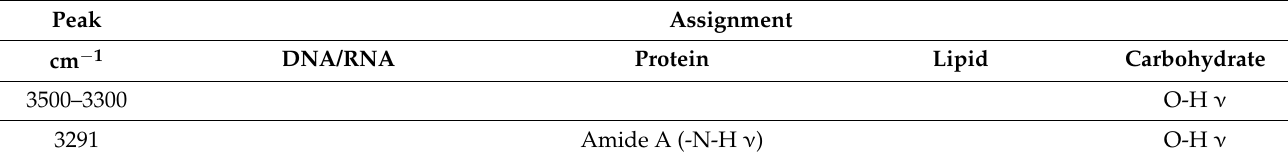
Table 2. FT-IR peaks observed in the spectrum of control cells, with assignments in agreement with the data reported in the literature [1,3,4,14,35,47]; abbreviation: as = asymmetric, s = symmetric, ν = stretching, δ = bending, sc = scissoring, vbr = vibration, a. a. = free amino acids. The indicated position of every peak is the centre of the relative Gauss-cross- Lorentzian function obtained from the deconvolution fit. The peaks indicated in bold character are obtained by the analysis of second